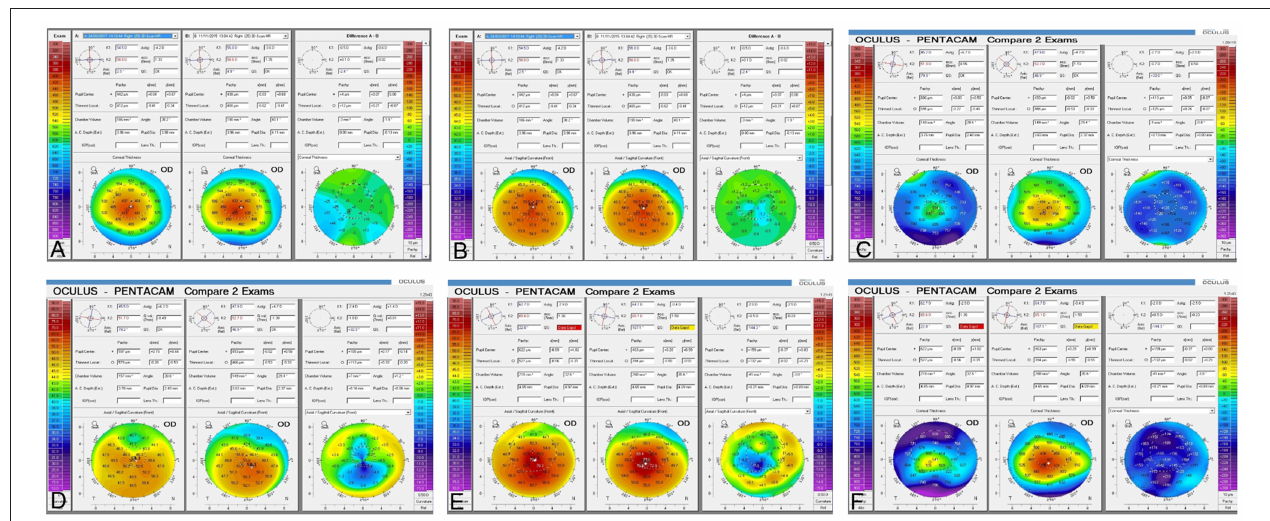
FIGURE 4 | Corneal topography (Pentacam) comparison between preoperative, 12 and 36 months post-op. (A) Comparative paquimetric examinations (right side) among the preoperative (middle) and 12 months post-op (left side) in case 1, G-1. Observe the modest improvement of the corneal thickness (B) Preoperative (middle) and 12 months post-op (left side) sagittal curvature comparative exams (right side), in case 1, G-1. Notice the modest improvement in the keratometric parameters of the cornea. (C) Comparative paquimetric examinations (right side) among the preoperative (middle) and 12 months post-op (left side) in case 6, G-2. Observe the improvement of the corneal thickness. (D) Preoperative (middle) and 36 months post-op (left side) sagittal curvature comparative exam (right side), in case 6, G-2. Notice the improvement in the keratometric parameters of the cornea. (E) Sagittal curvature comparative exam (right side) among the preoperative (middle) and almost 3 years post-op (left side) in case 12, G-3. Enhancement of the keratometric parameters can be observed. (F) Comparison pachymetric exam (right side) among the preoperative (middle) and 3 years post-op (left side) in case 12, G-3. The markable enhancement of the paquimetric parameters can be